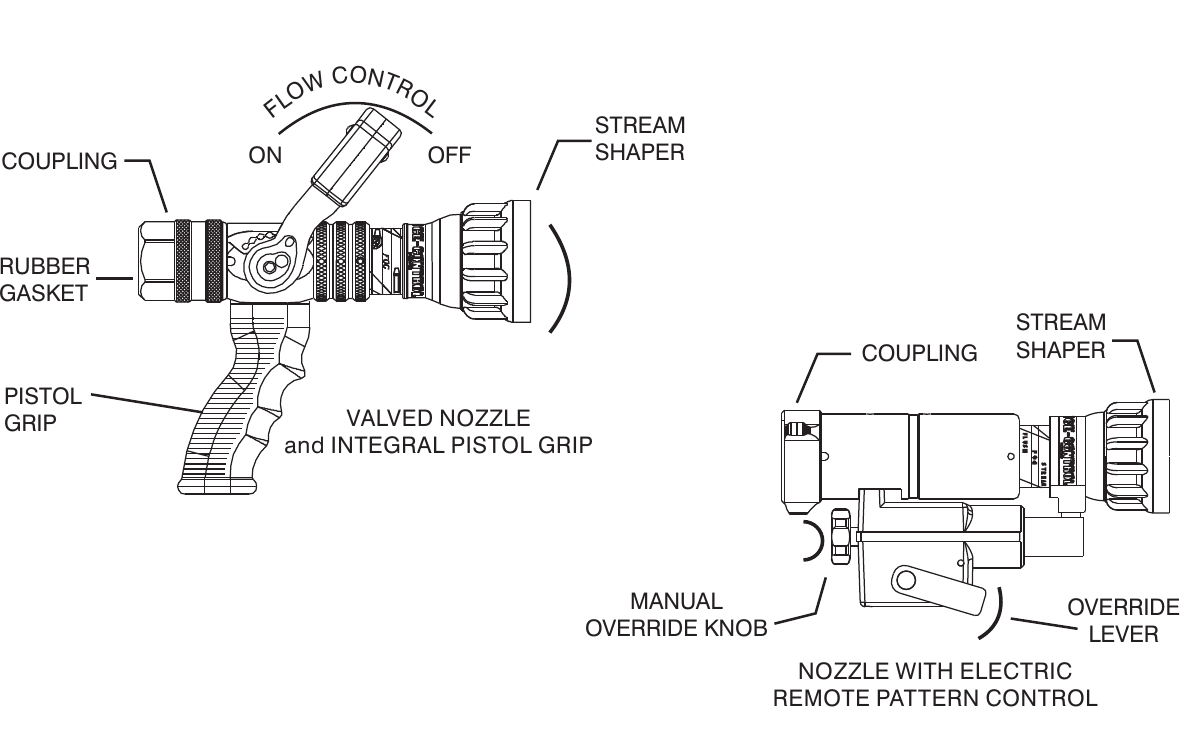
FIGURE 1 - COMMON MODELS AND